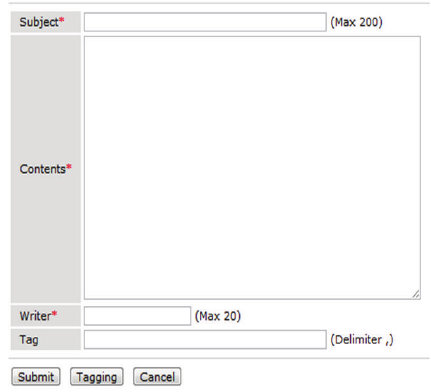
Figure 5: User input screen.